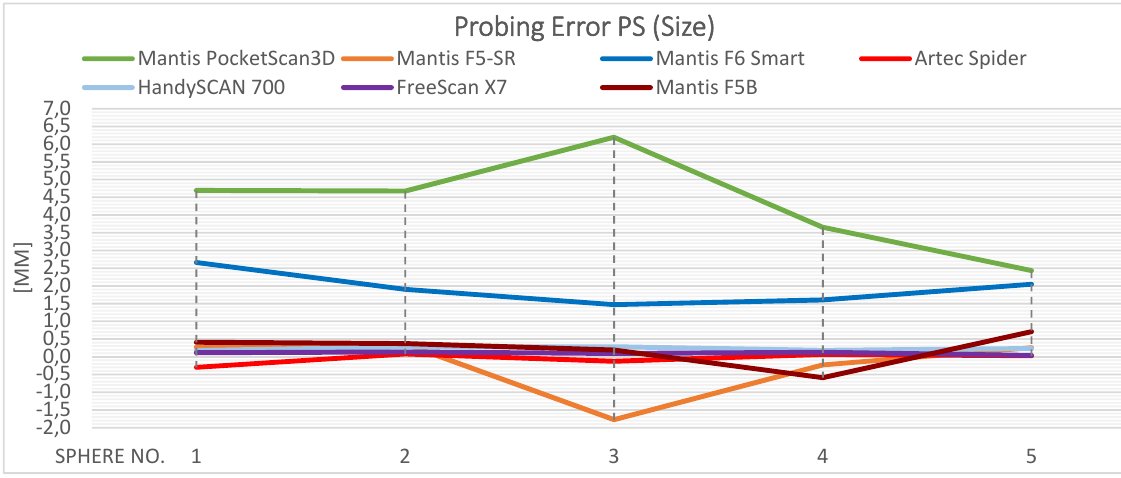
Figure 4. Quality parameter probing error size (PS) equivalent to VDI/VDE 2634, part 2